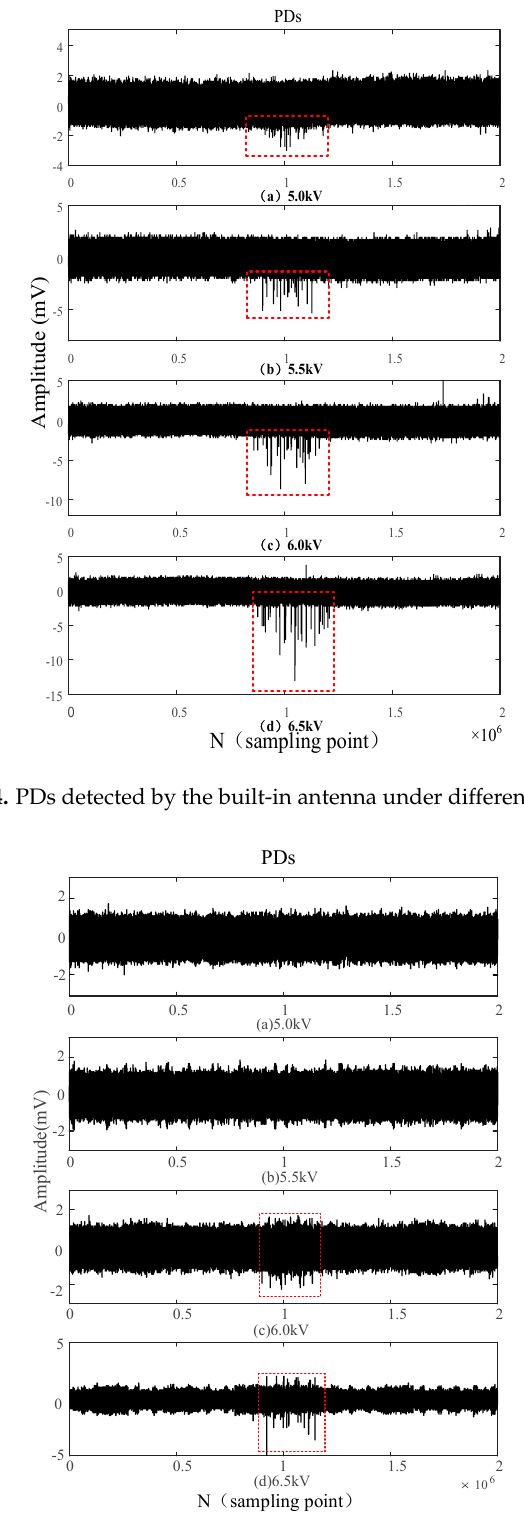
Figure 15. PDs detected by the external antenna under different voltages.